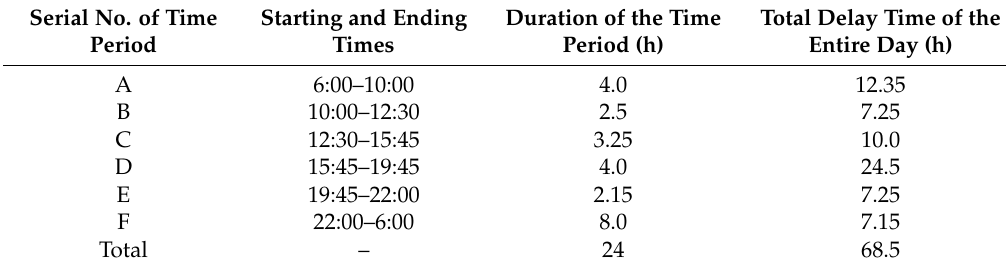
Table 2. Time-of-day division scheme under 3D vector time period division of the intersection at Yangming North Road and Renmin East